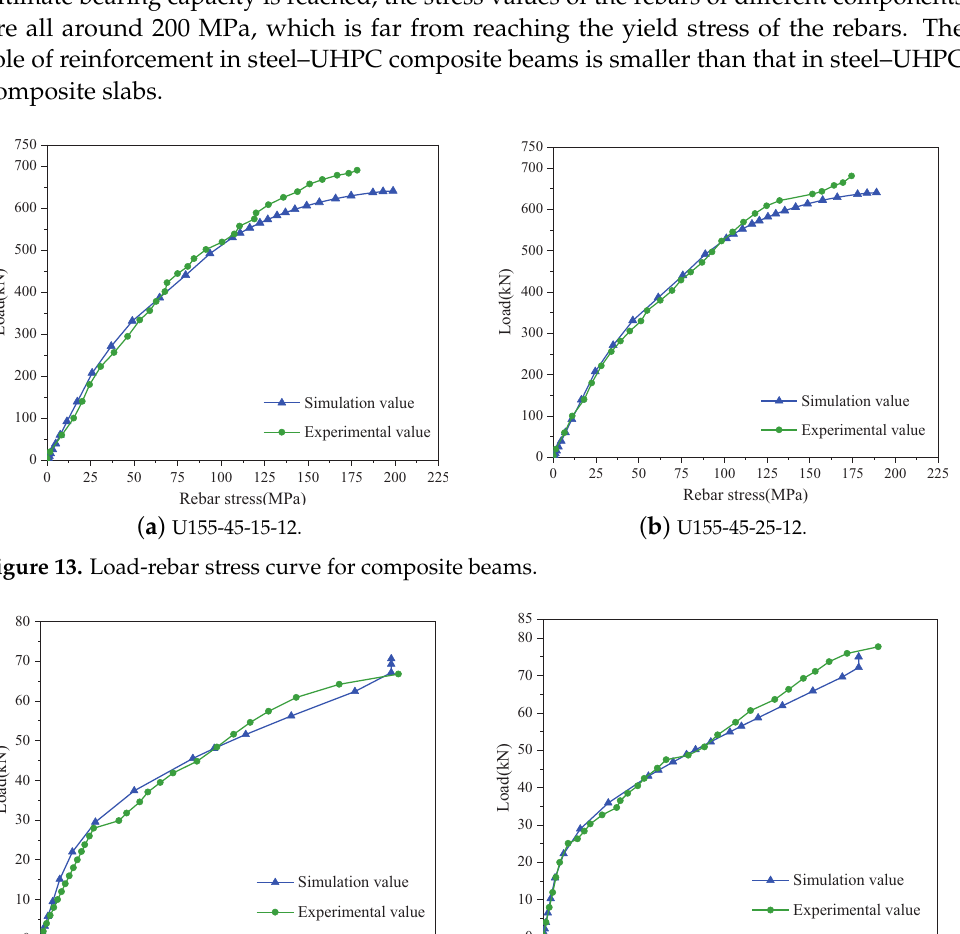
( a ) S150-60-15-4. ( b ) S150-60-25-6. Figure 14. Load-rebar stress curve for composite